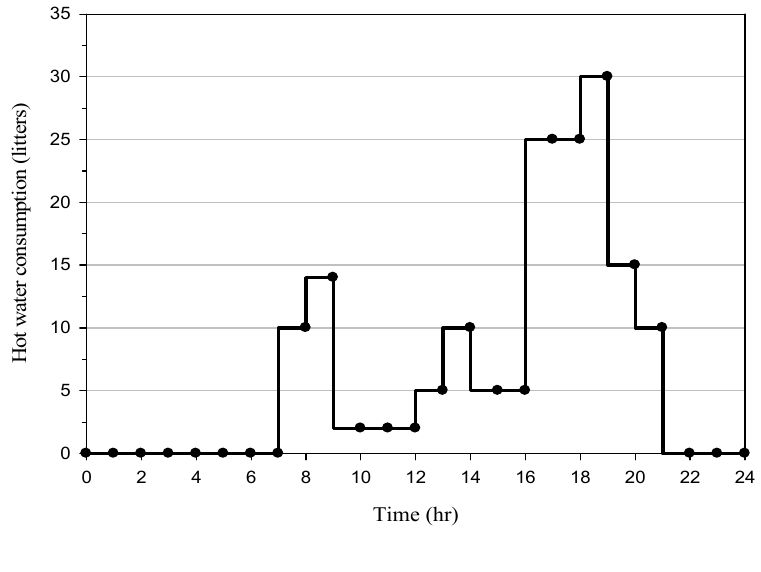
Figure 7. Average daily water consumption profile.